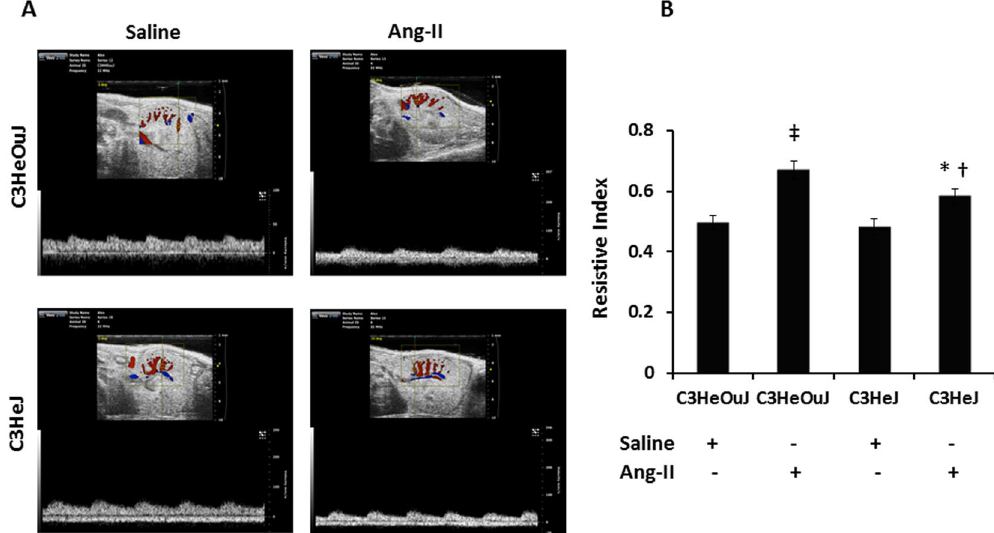
Figure 2. The resistive index of intrarenal cortical artery is decreased in TLR4 deficiency mice to Ang-II. ( A ) Representative images of left kidney in short axis. The transducer is fixed to obtain a window showing cortical vessels. The pulse wave cursor is then centered on a cortical artery with its axis in parallel and vascular signals are obtained. Resistive index is calculated by the formula (PSV-EDV)/PSV. PSV, peak systolic velocity; EDV, end diastolic velocity. ( B ) Bar graph shows mean resistive index ± SEM. n = 6/group tested by ANOVA and Student’s t-test. * p < 0.05 vs. C3HeJ + saline, † p < 0.05 vs. C3HeOuJ + Ang-II, ‡ p < 0.05 vs. C3HeOuJ + saline. C3HeOuJ: normal TLR4, C3HeJ: TLR4 deficiency.